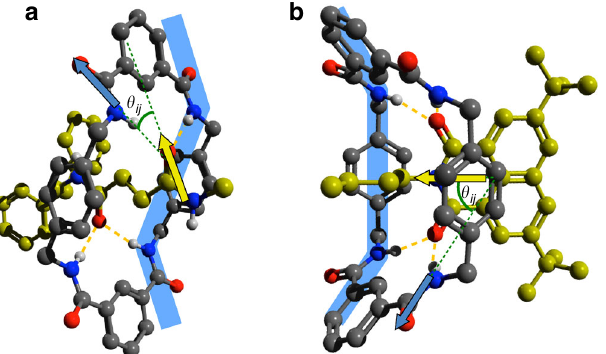
Fig. 4 Conformations of the macrocyclic ring, hydrogen bonded to the initial and fi nal station of the molecular shuttle. a Optimised geometry of the macrocyclic ring, hydrogen bonded to the succ station. b Optimised geometry of the macrocyclic ring, hydrogen bonded to the ni (cid:129) − station. In both cases, the conformations are optimised at the B3LYP/6-31G(d) level. The C atoms of the stations are coloured yellow, and the macrocycle ⋯ station hydrogen bonds are indicated by dashed orange lines. The transition-dipole-moment vectors, whose relative angle θ ij can be determined from the cross-peak anisotropies in the (T)2DIR spectra, are indicated by green arrows, their protractions by green dashed lines. The macrocycle conformation is indicated in light